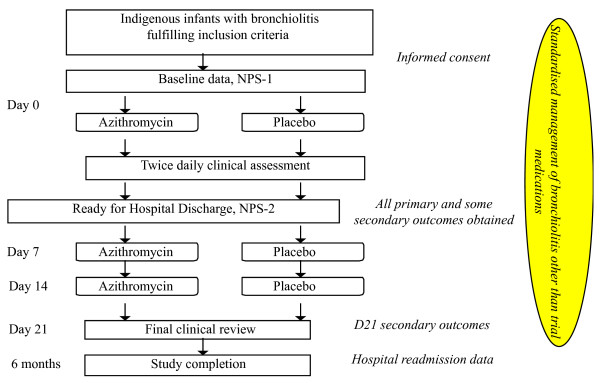
Overall schematic study plan.